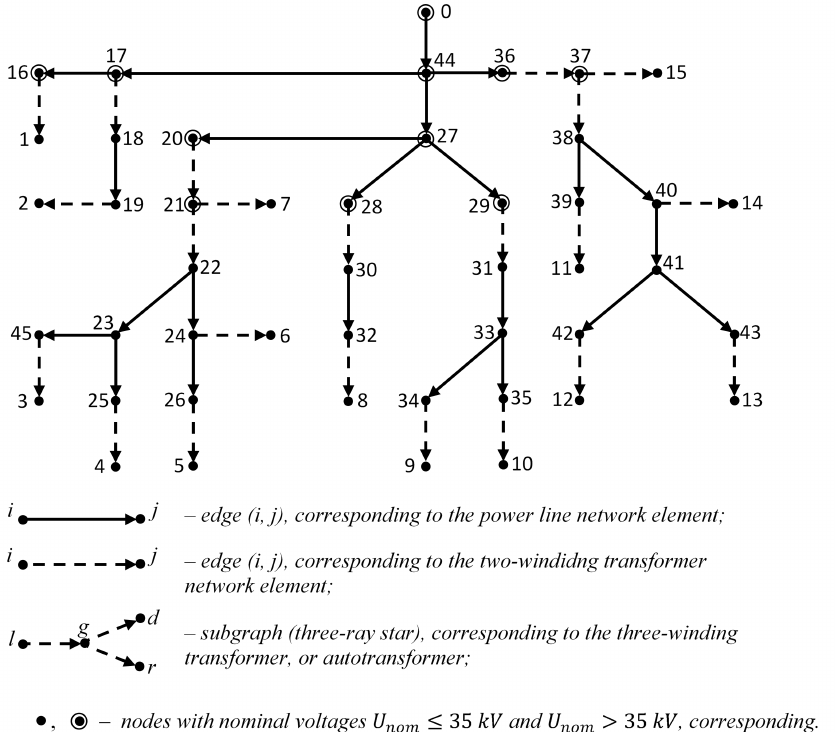
Figure 1. Graph of a radial electrical network with different rated